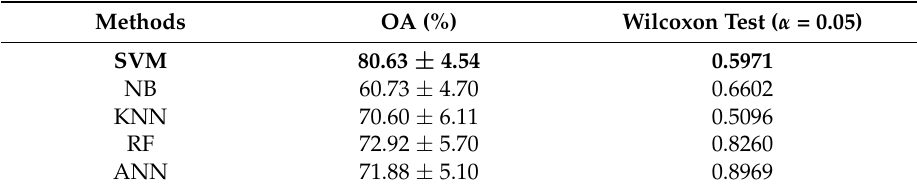
Table 4. Accuracies of MOSCRF based on different classifiers.